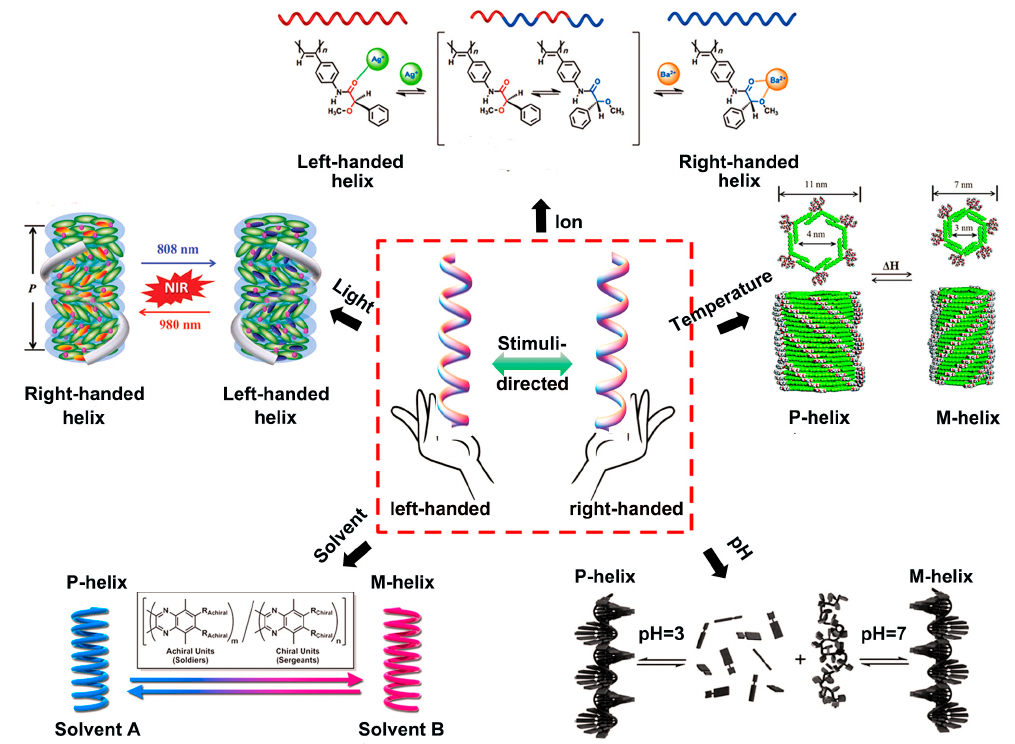
Figure 1. Schematic illustration of helical chirality inversion through different external stimuli, such as solvent, light irradiation, ion, temperature and pH. Typical examples for these modulate methods are also displayed. Reproduced from [21–25] with copyright permission.